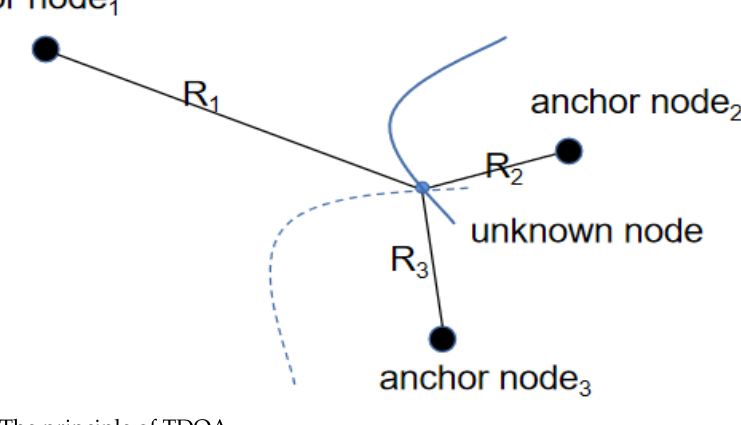
Figure 1. The principle of